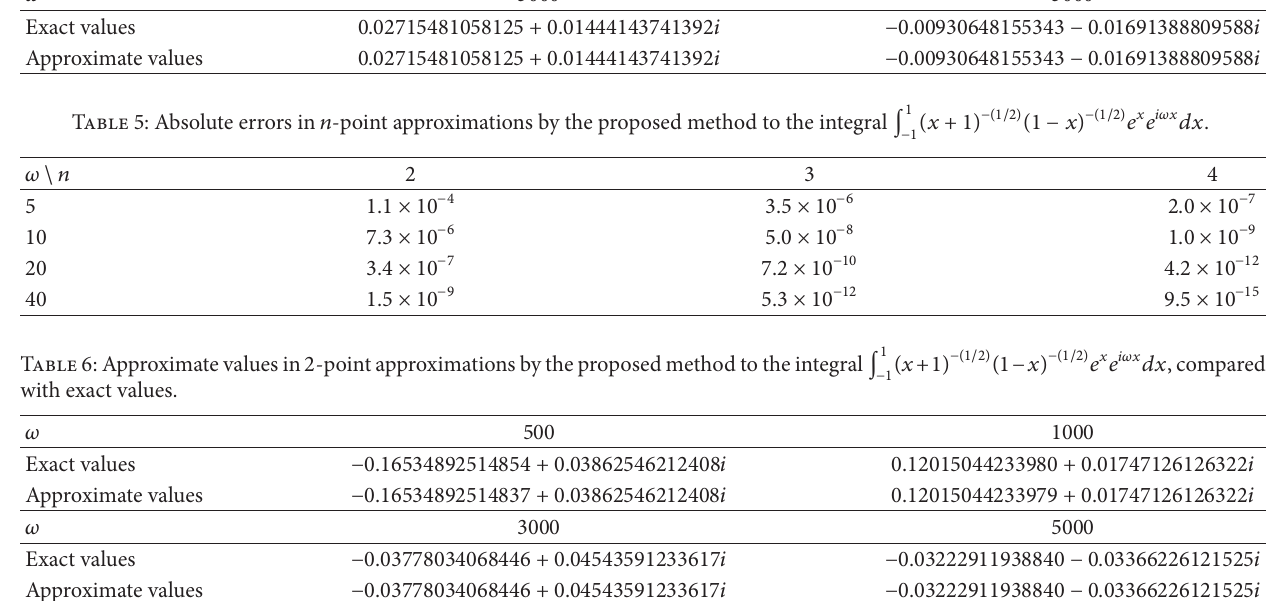
1 (𝑥 + 1) −(1/2) (1 − 𝑥) −(1/2) 𝑒 𝑥 𝑒 𝑖𝜔𝑥 𝑑𝑥 . −1